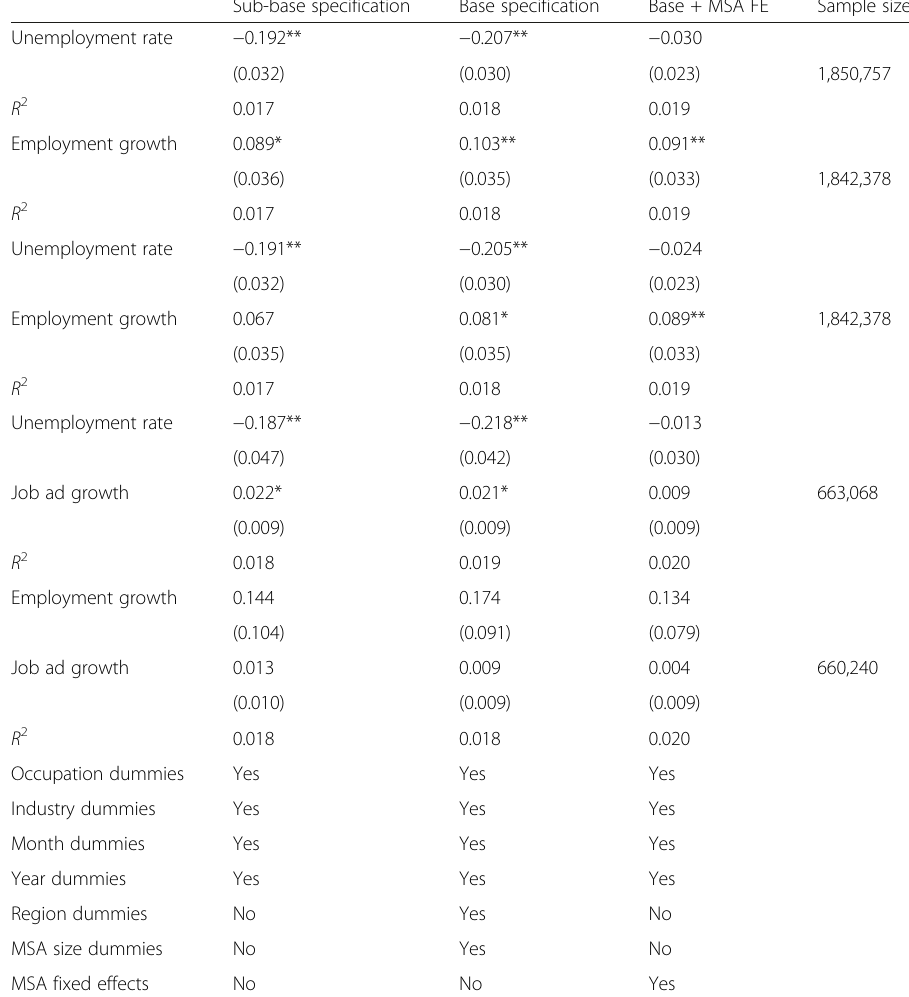
Table 5 Effects of unemployment, employment growth, and job ads on multiple job